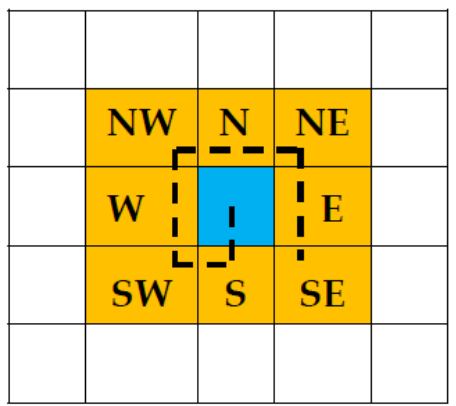
Figure 3. Moore’s Neighbor Pixels. Blue is the pixel of interest, and yellows are the surround- ing/neighbor pixels.